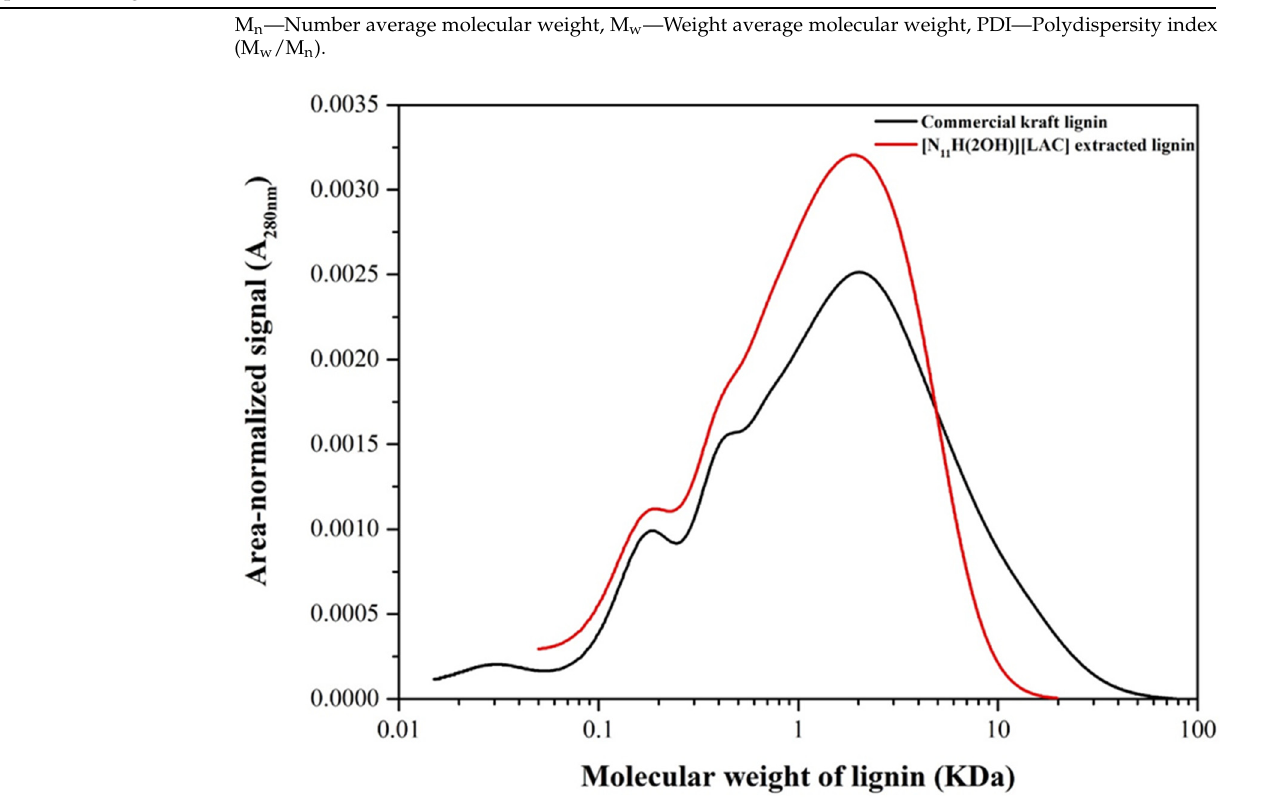
Figure 6. Molecular weight distribution of [N11H(2OH)][LAC]-extracted lignin from pine biomass and commercial Kraft lignin. Table 1. Molecular weight properties of [N11H(2OH)][LAC]-extracted lignin from pine wood bio- mass and commercial Kraft lignin.